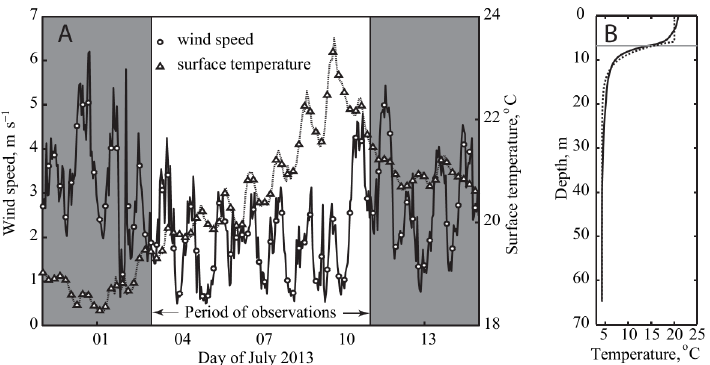
the epilimnion determined from location of the maximum vertical temperature